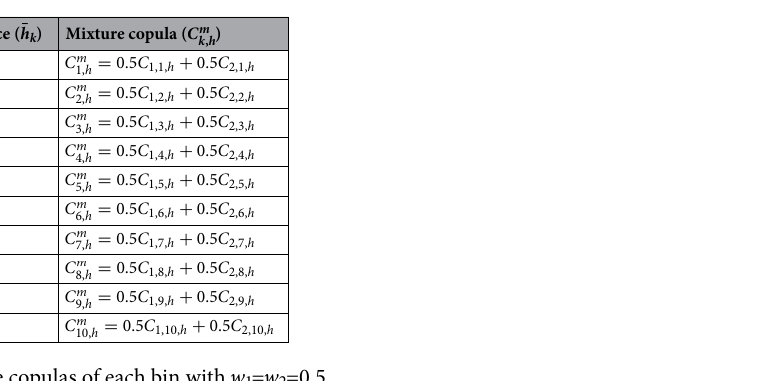
spatial dependence in the univariate prediction, were compared with the existing univariate pair copula, NLPCA spatial copula and cokriging methods, respectively. The results showed that the proposed spatial mixture copula model outperformed the existing methods in terms of the minimum values of RMSE, MAE, MAPE, and KDE MSE. The method also applied to non-linear simulated bivariate correlated variables (see Supplementary online), where the spatial mixture copula outperformed the existing methods, in terms of predicting individual simu- lated variables and their bivariate relationship. The proposed method used equal weights for each variable for both BEF application and simulation study. However, further improvement to the spatial mixture model is the optimal weights selection of each variable in the mixture copula modelling. For instance, one spatial variable may have a strong spatial dependence across locations than the other variable, and the optimal weights selection may increase the prediction accuracy of each variable across locations. The prediction method is explained for the bivariate case (m = 2), however, it can be extended to multivariate setting. Also, the proposed spatial mixture copula can be extended to multivariate spatial sampling design methodology for optimally selecting additional sampling to reduce prediction uncertainty by leveraging spatially correlated multiple variables. Moreover, the proposed method assumes isotropic spatial dependence of spatial variables but can be extended to model spatially correlated anisotropic variables, which can be present in mining 36 and soil variables 37 , for example. The proposed method assumes that the spatial random field is stationary. However, the method can be extended to non-stationary spatial processes. For example, a non-stationary spatial process can be divided into several locally stationary processes. A univariate spatial copula can be modelled to each stationary process, and then a global non-stationary spatial copula can be constructed as a mixture of locally stationary spatial copulas. Furthermore, the proposed method assumes that all data points are known and collected at the same set of locations. However, measurements could be unavailable or difficult to sample at some locations, which is quite